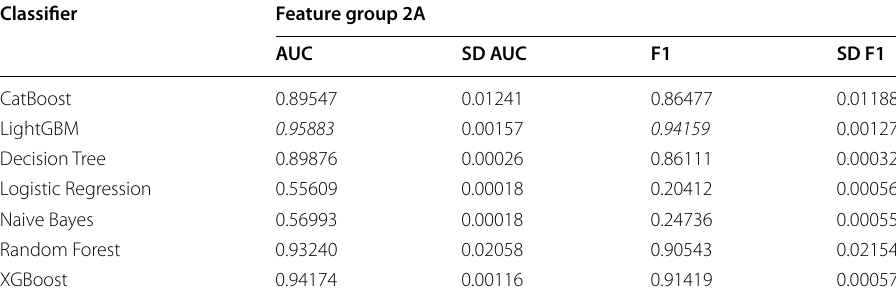
Table 26 Mean performance of 7 classifiers in terms of AUC and F1-score on datasets with features from feature group 2A